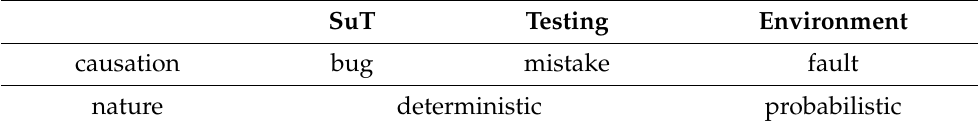
Table 1. Terminology distinguishing Bugs, Mistakes, and